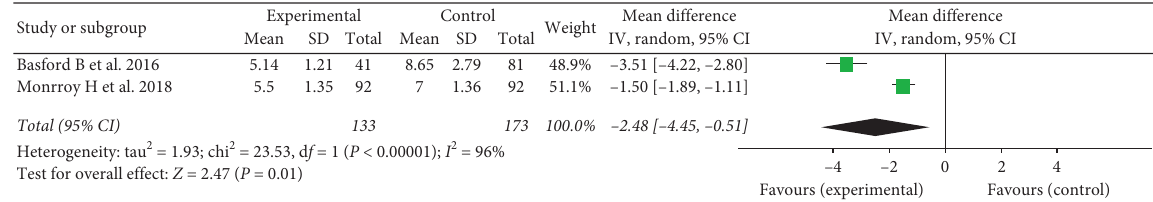
Figure 6: Forest plot of Total Mucosal Visibility Score (McNally) between combination premedication agent (Simethicone +N- Ace- tylcysteine) and